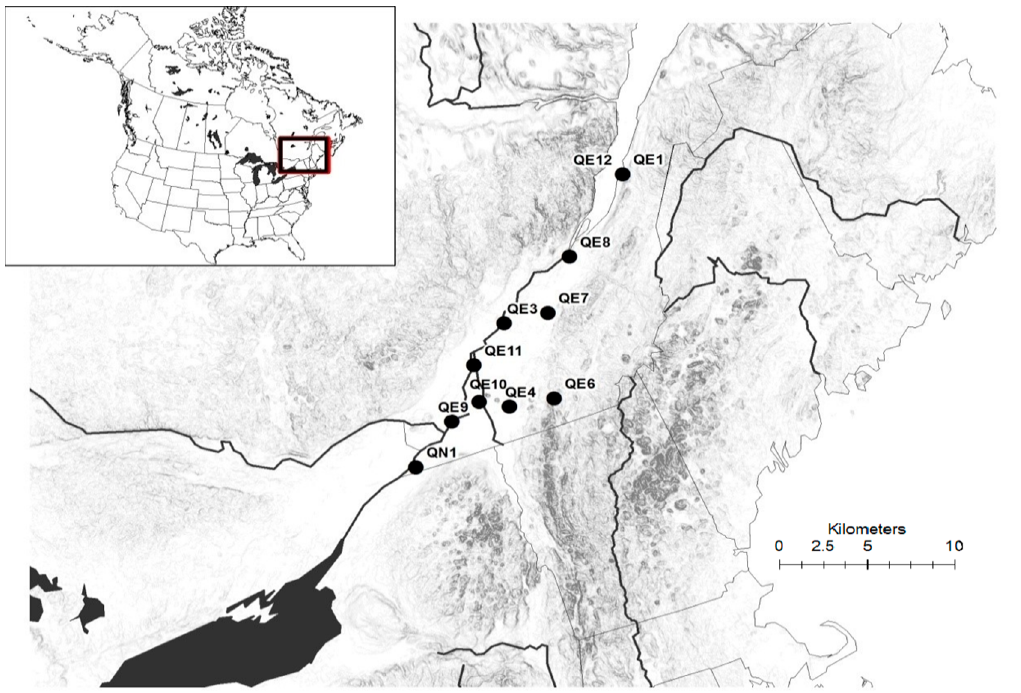
Figure 7. Map of the study area showing the distribution of sampling sites in different habitats of Quebec, Canada.